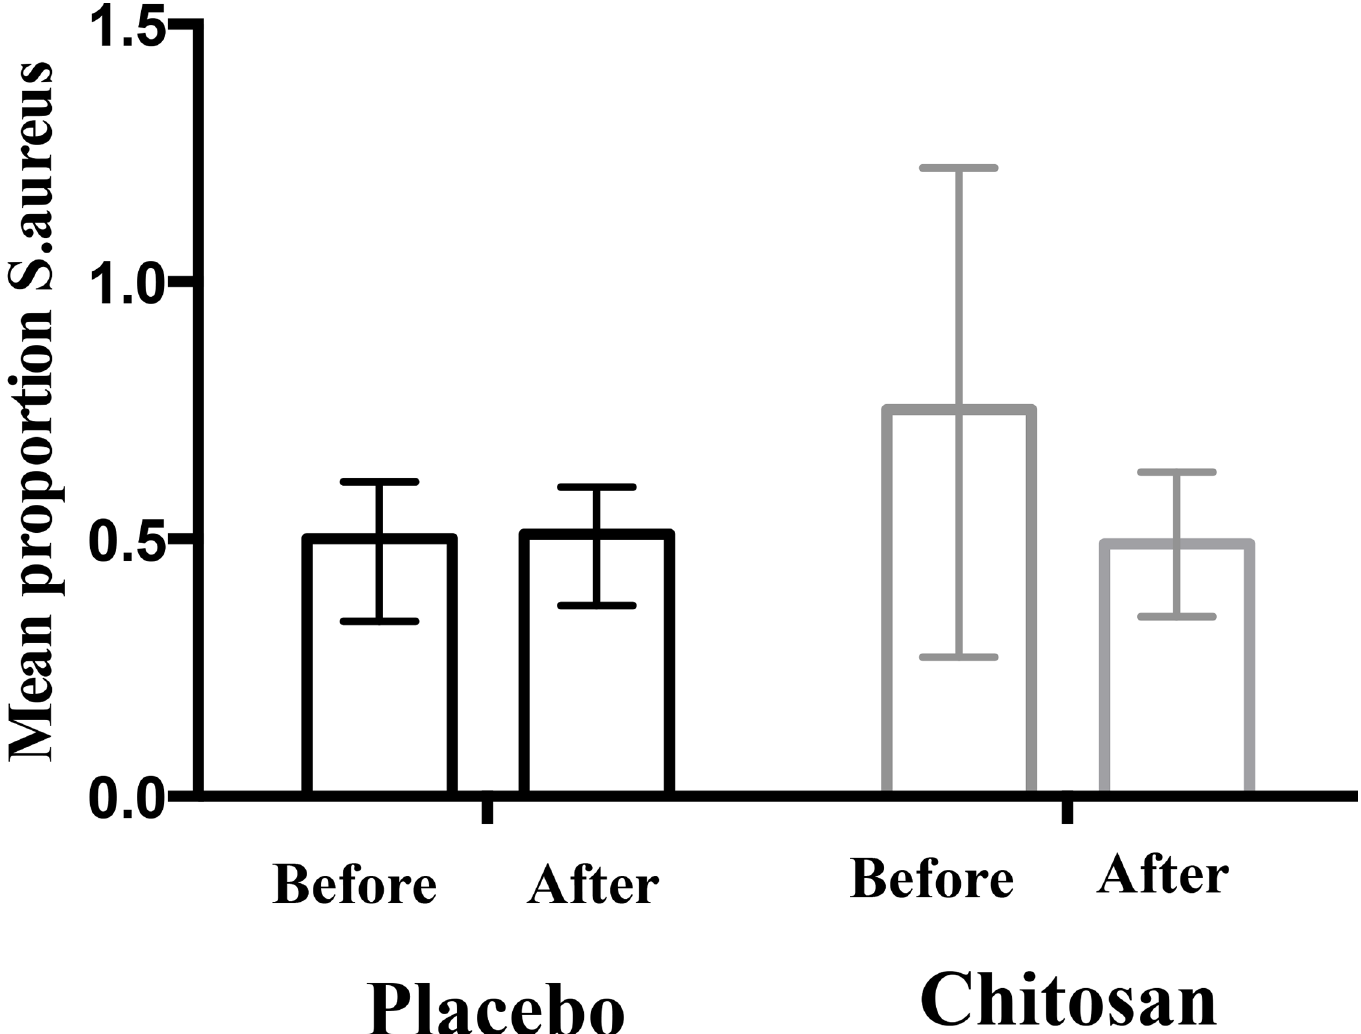
Fig 4. Mean (95% CI) Staphylococcus aureus colony forming units in all regions as proportion of total staphylococcal counts before and after intervention in placebo and chitosan groups. CI-confidence